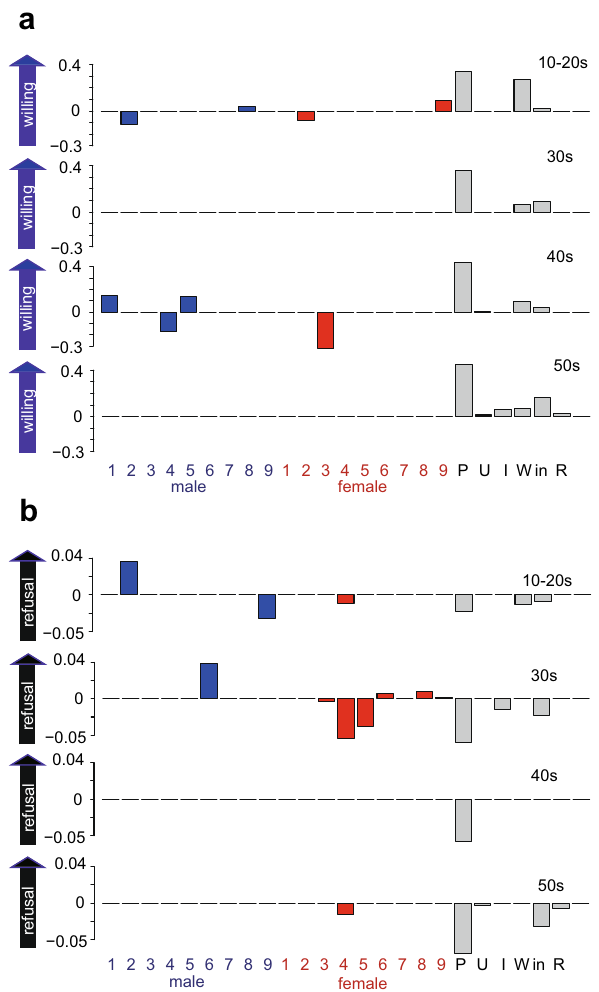
Figure 3. LASSO analysis of the contribution of each nudge on the willingness to be vaccinated for different ages and genders. For each age group, willingness ( a ) and refusal ( b ) to be vaccinated were regressed using LASSO, with the following variables as regressors: the interaction between nudge and gender, degree of usual prevention, underlying disease, infection in close relatives, workplace, income, and place of